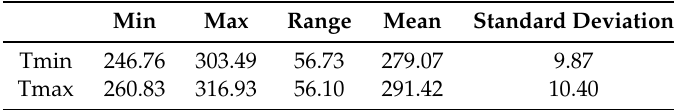
Table 1. Summaries of air temperature (units: